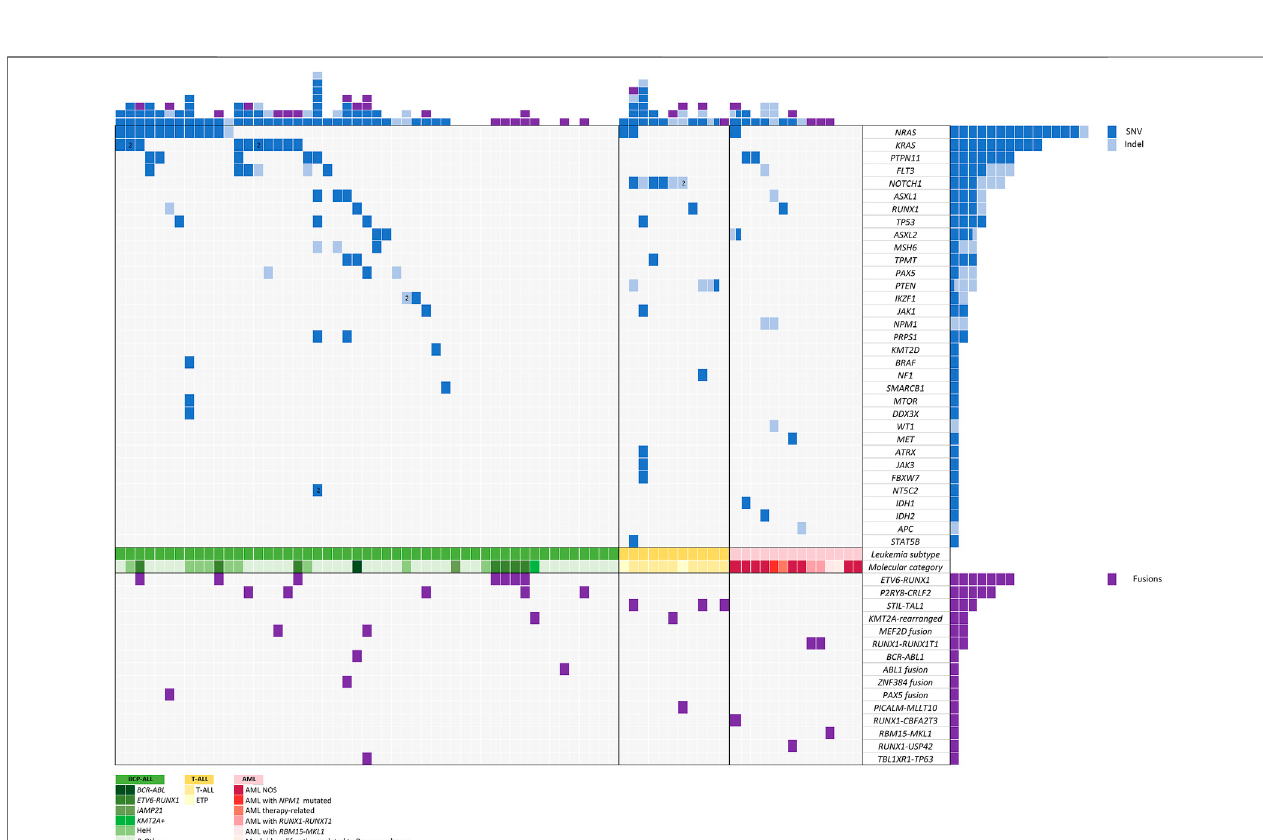
FIGURE 4 | Mutation and gene fusion distribution across the different patients analyzed.